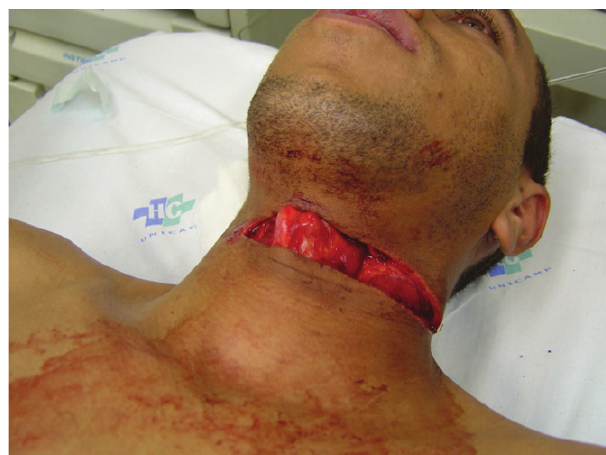
Figure 1 - The victim was riding a motorcycle and suffered a cervical penetrating trauma.